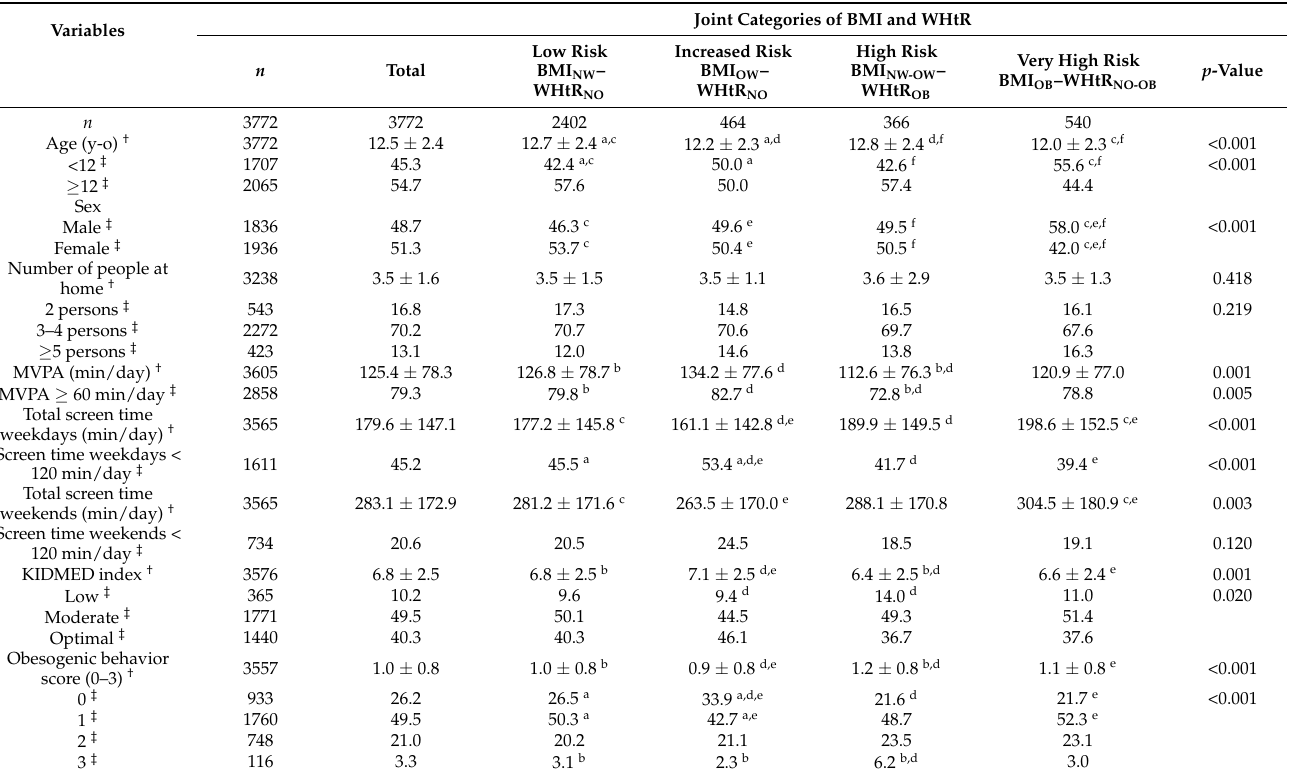
Table 1. Descriptive characteristics of the study population relative to joint categories of body mass index (BMI) and waist-to-height ratio (WHtR).